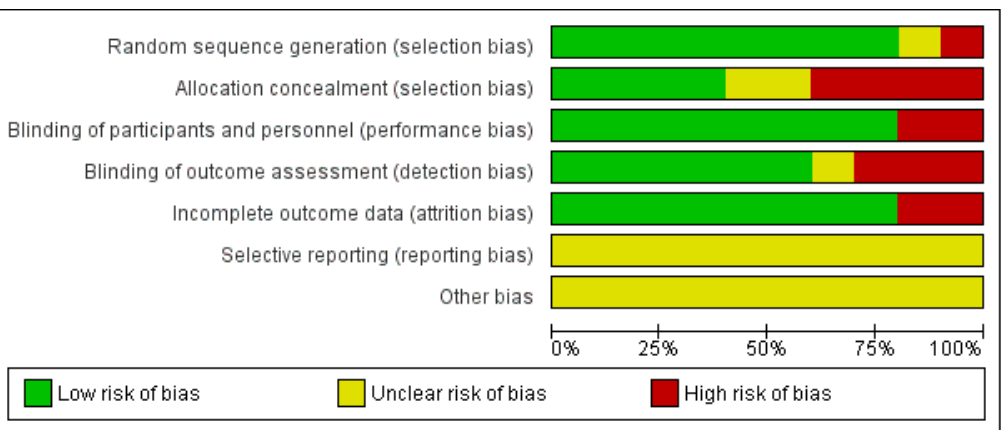
Figure 3. Risk of bias